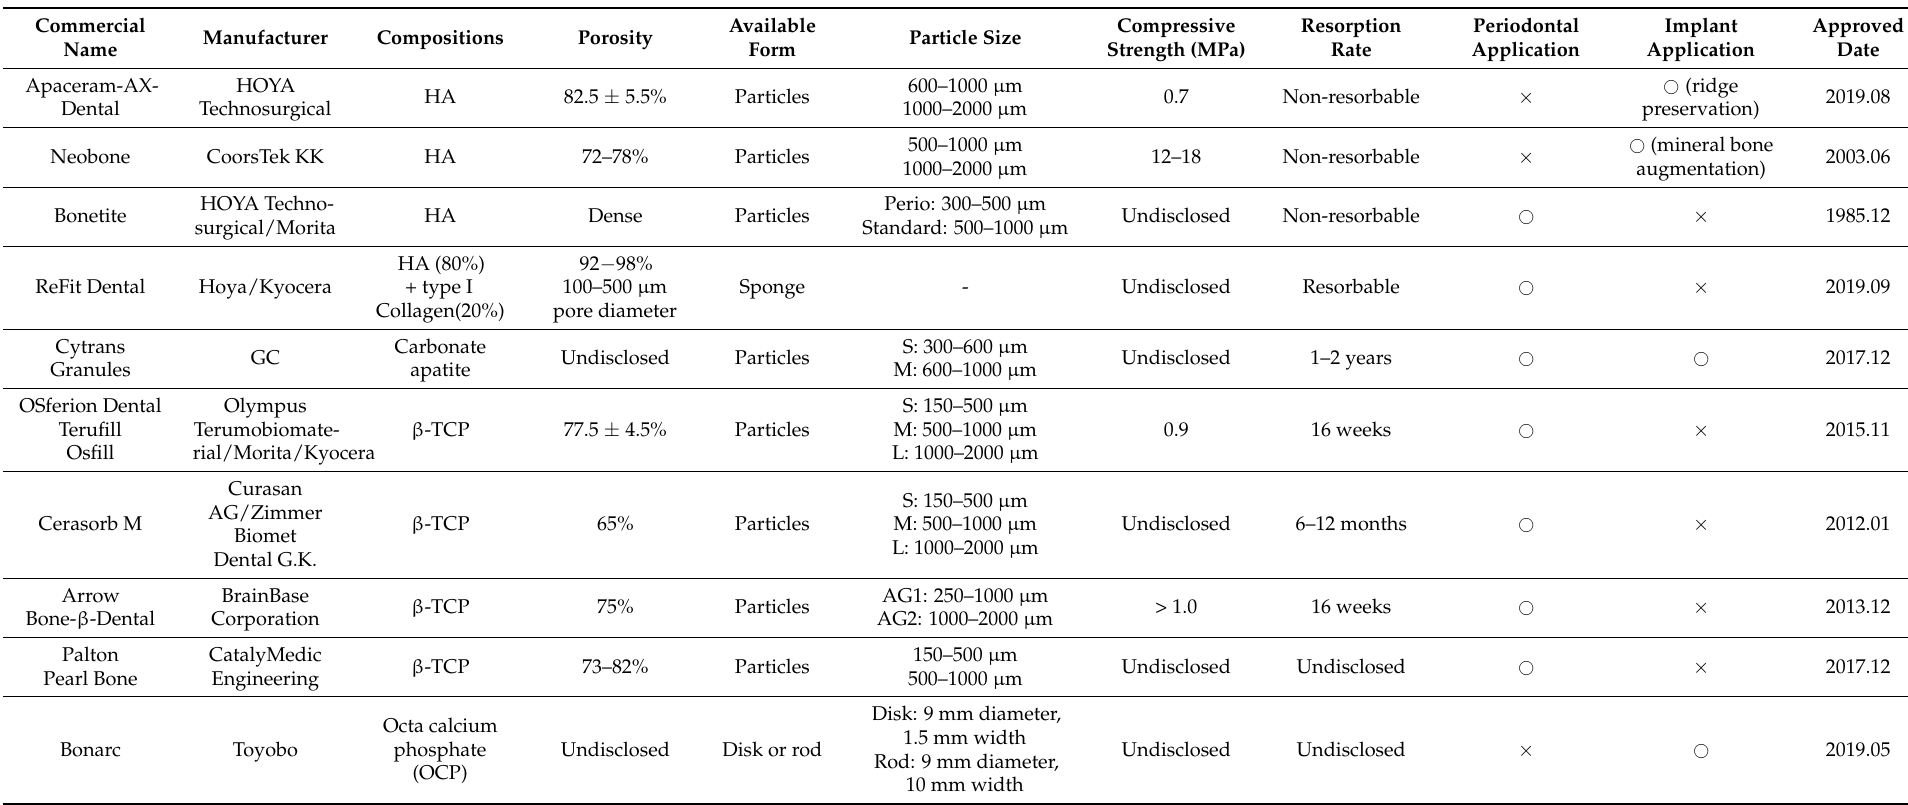
Table 2. Dental alloplastic bone substitute products for periodontal and oral implant applications approved by the Japanese Pharmaceuticals and Medical Devices Agency.